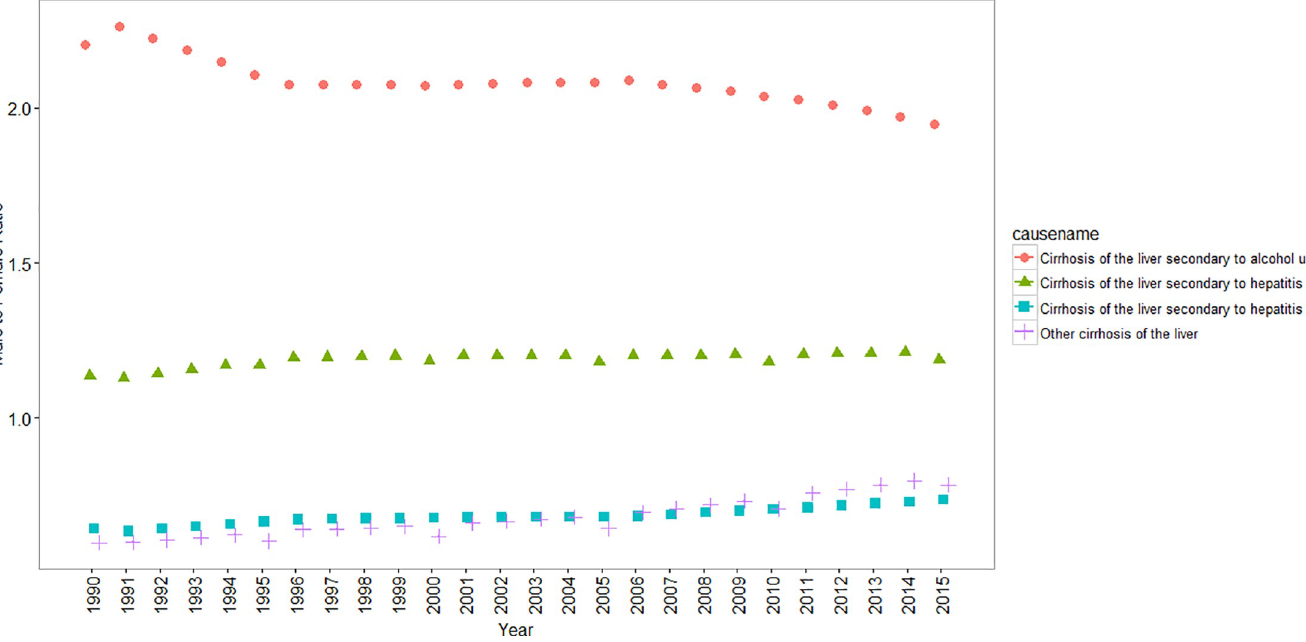
Fig 7. Male to Female age-adjusted liver cirrhosis mortality ratio between 1990 and 2015 by cause in Iran.